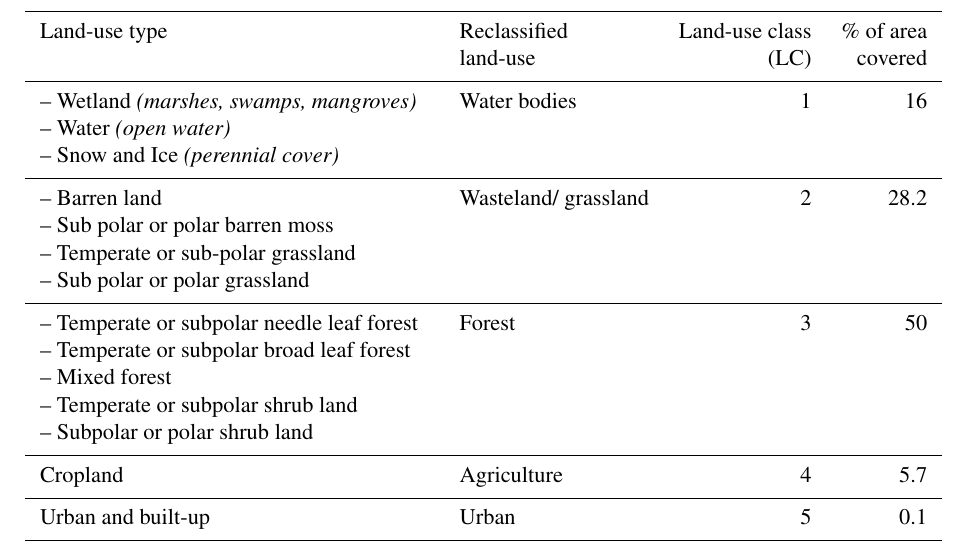
Table 2. Classes of land-use types in Canada along with their percent of area covered.